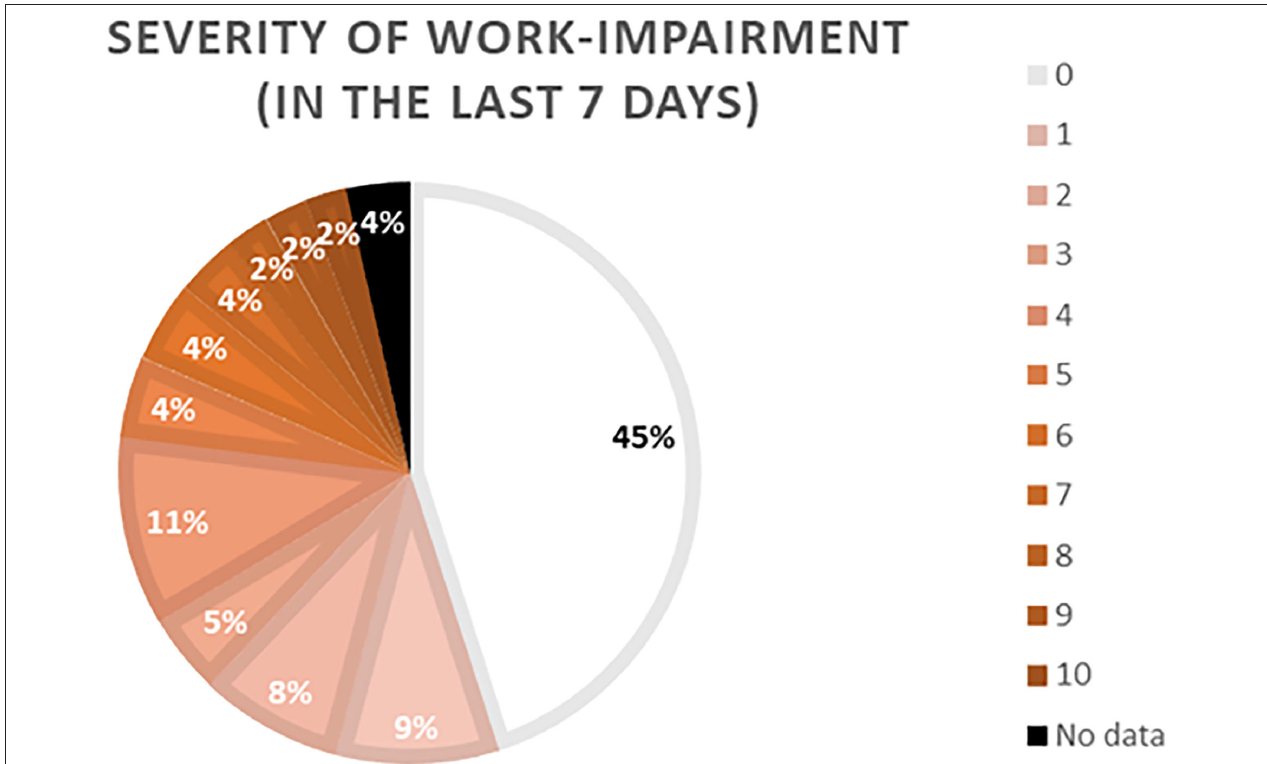
FIGURE 3 | Depiction of the patient’s rating of their severity of work impairment in the last 7 days due to cholinergic urticaria (CholU) symptoms. Patients could rate on a 10-point Likert scale ranging from 0 (no impairment) to 10 (max. impairment).